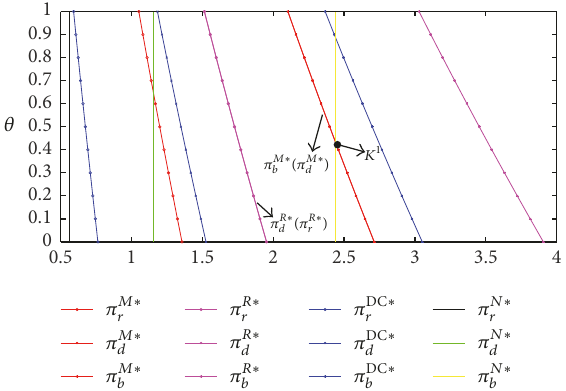
Figure 7: Effects of 𝜃 on benefits of supply chain